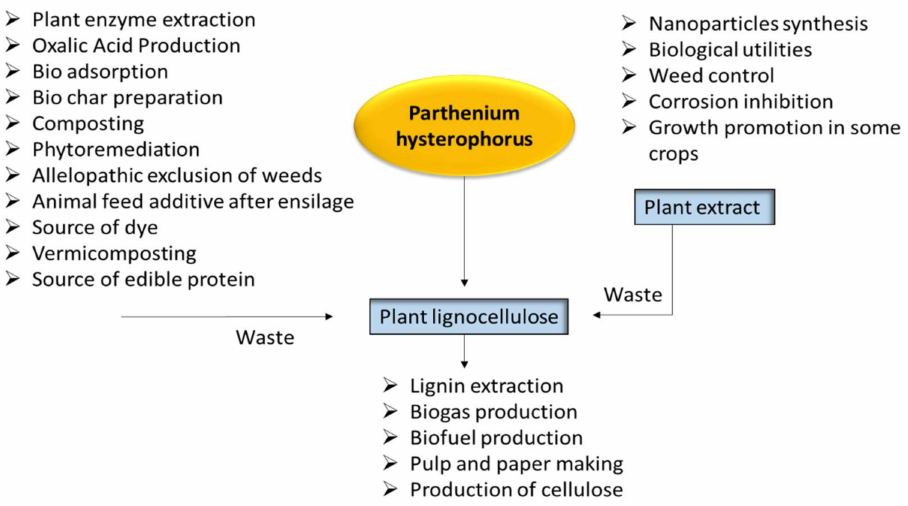
Figure 5. Sources of economic benefits of Parthenium hysterophorus